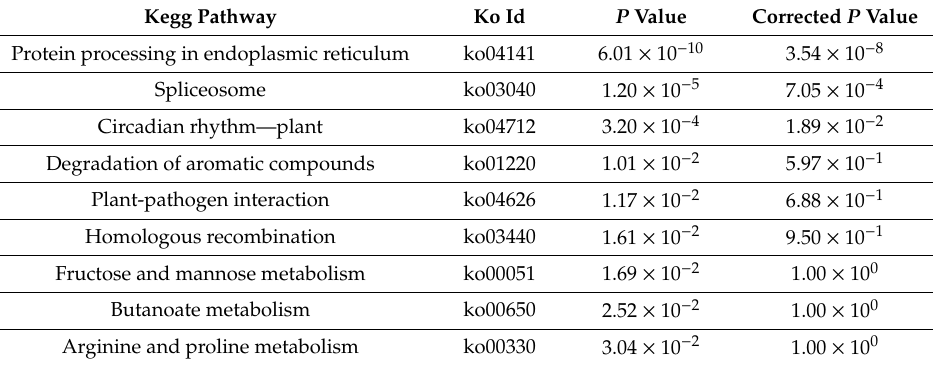
Table 1. Major metabolic pathways related to wheat tillering ( P < 0.05).